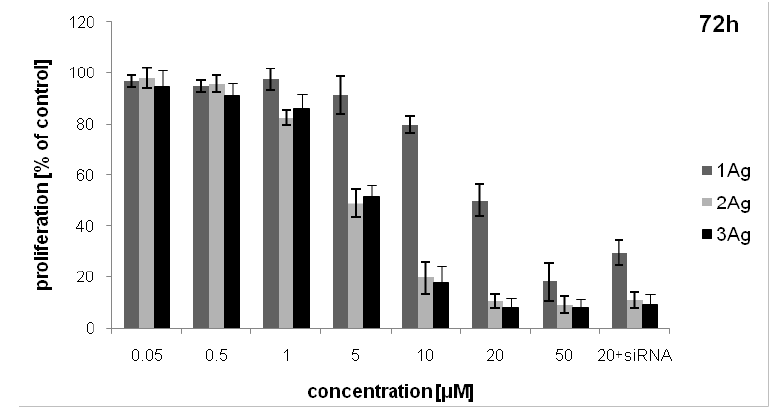
Figure 9. Inhibition of lymphocyte proliferation by AgNPs and their complexes with siRNA (siBcl-xl) after 72 h of treatment. The abscissa values refer to the dendron concentration. Data presented as percentage of viability of control (PHA-treated) cells, mean ± SD, n = 3.